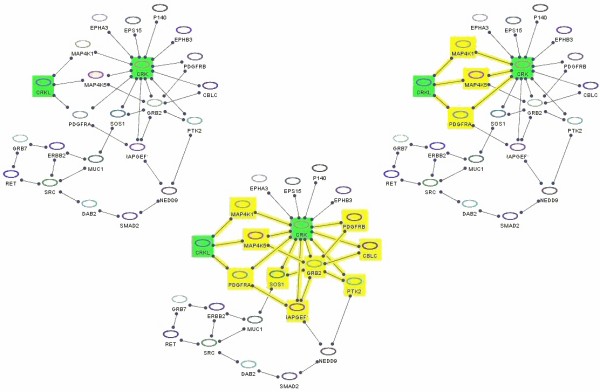
Graph of interest. (left) A PPI network with proteins of interest CRK and CRKL (green); (middle) Graph of interest (yellow) formed by using paths of length up to 3 (k = 3) between nodes of interest (green); (right) Graph of interest with k = 2 (k = 1 returns no results).